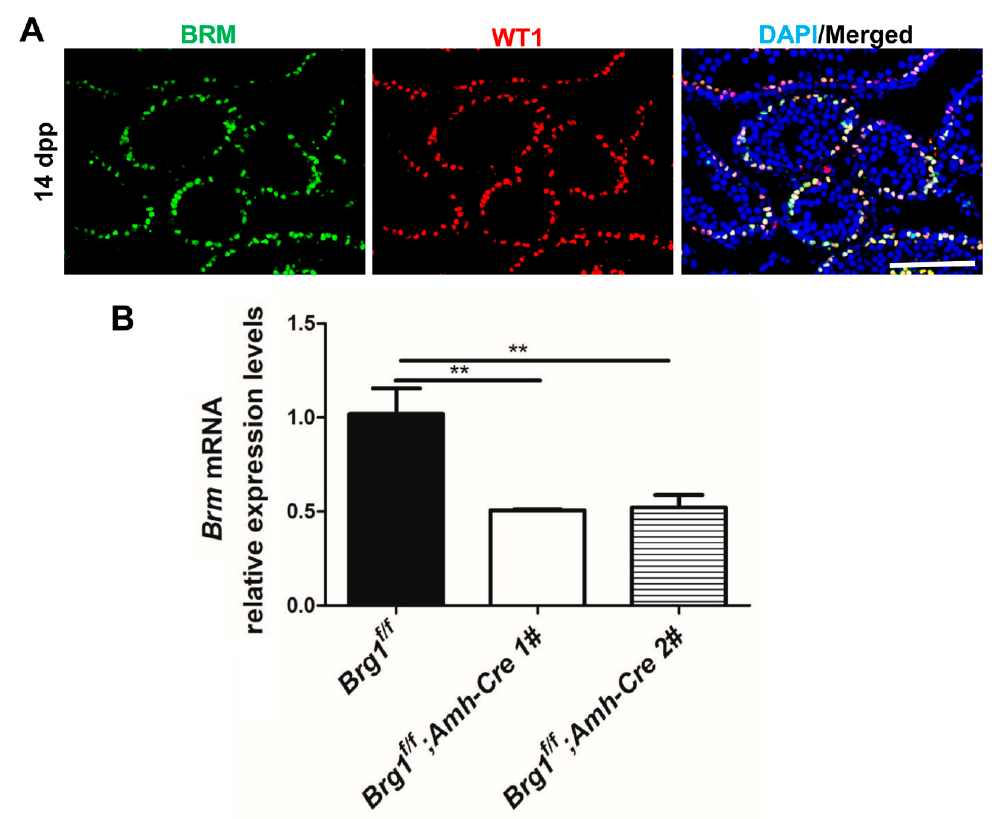
Figure 5. BRM is exclusively expressed in Sertoli cells and Brm expression in isolated Brg1-cKO Sertoli cells . ( A ) BRM and WT1 expression was examined with IHF in Sertoli cells from 14 dpp mice.